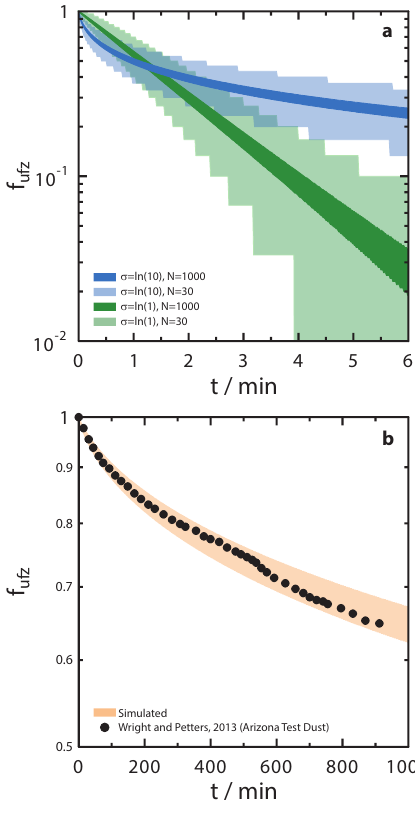
Figure 1. Sensitivity calculations of the unfrozen droplet fraction, f ufz , as a function of time, t , derived from model simulations for a total number of droplets, N tot , and variability of ice nucleating particle surface area, σ g . (a) Model simulated 5th and 95th per- centile bounds of f ufz are shown as dark green (Iso1), light green (Iso2), dark blue (Iso3), and light blue (Iso4) shading. Parameter values are given in the legend. (b) Simulated 5th and 95th percentile bounds of f ufz derived from IsoWR are shown as the orange shad- ing along with experimental data of isothermal immersion freezing by Arizona test dust (Wright and Petters, 2013) shown as black cir- cles. Parameter values for all model simulations in (a) and (b) are given in Table